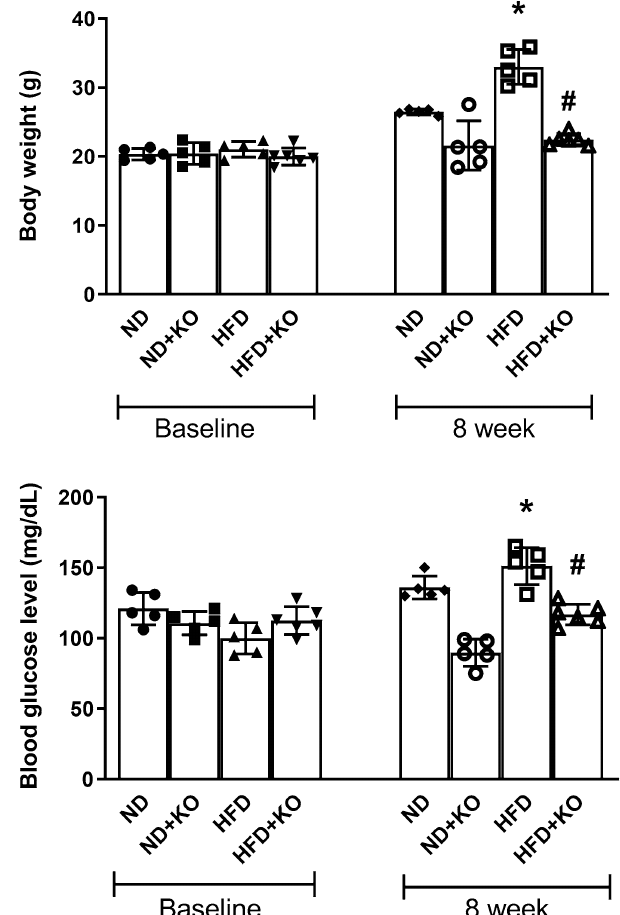
Figure 1. Body weight and plasma glucose. Body weight and plasma glucose level after 8 weeks following normal diet (ND) and high fat diet (HFD) in mice with or without Atp6ap2-KO. Data presented as mean ± SEM, * P < 0.05 versus HFD; # P < 0.05 versus HFD + KO, n = 5–6 each